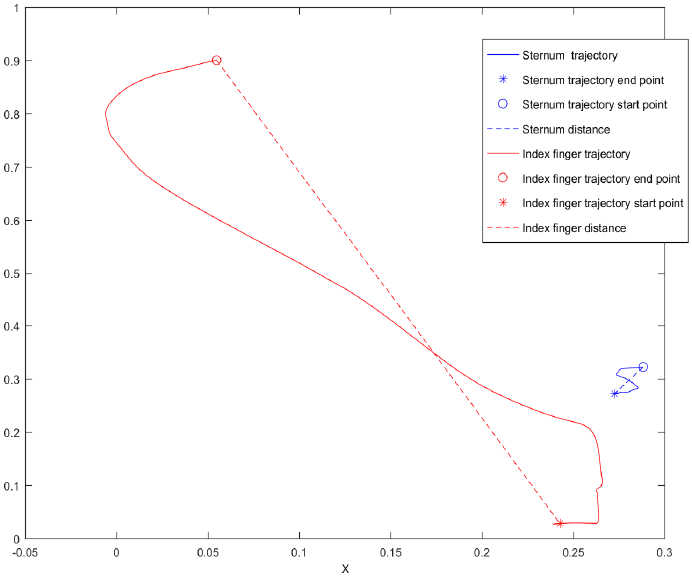
Fig. 2. The ARC index in the frontal plane during the lifting phase of a large cylinder for a G1